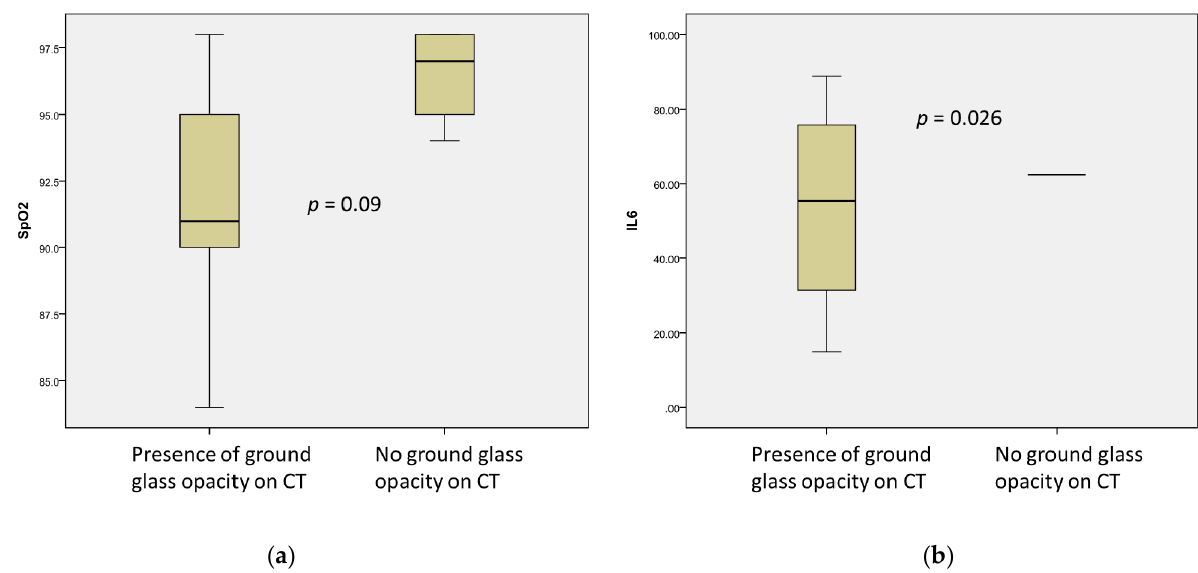
Figure 2. Association of ground-glass opacity (CT of lungs) with Sp02 (( a ), n = 12) and IL-6 (( b ), n = 9) levels.